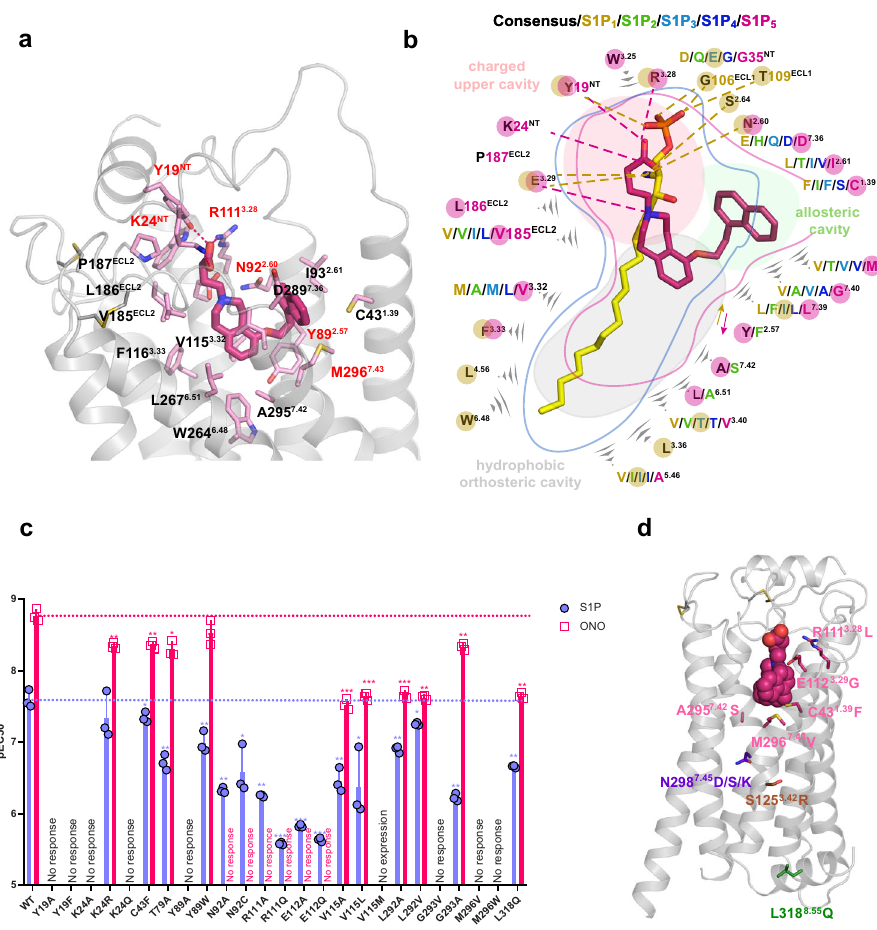
Fig. 2 | Structural and functional comparison between ONO-5430608 and S1P binding. a Binding pose of ONO-5430608 (pink, thick sticks) in S1P 5 and its inter- actions with the receptor residues (light pink, thin sticks). Polar interactions are shown as dashed lines. Residues that had mutations disrupting response to ONO- 5430608are labeled inred. b Schematicdiagram of the ligand binding pocket and interactions between ONO-5430608 and S1P 5 (this work, PDB ID 7YXA) compared to interactions between S1P and S1P 3 (PDB ID 7C4S). Residues are color-coded according to different S1P receptor subtypes (S1P 1 – yellow, S1P 2 – light green, S1P 3 – lightblue, S1P 4 – darkblue,S1P 5 – pink).Blackstandsforthe consensusresidue shared by all receptors. Residues interacting with ONO-5430608 are highlighted with pink circles, residues interacting with S1P are highlighted with yellow circles.